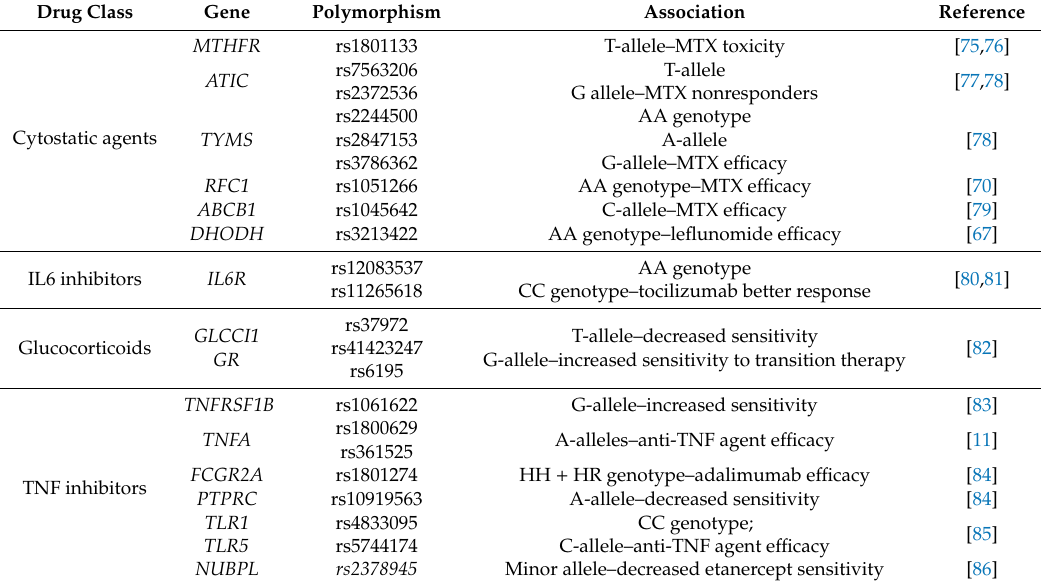
Table 2. Polymorphisms (non-HLA genes) associated with disease-modifying antirheumatic drugs (DMARD) e ffi cacy, according to meta-analyses and multicenter studies